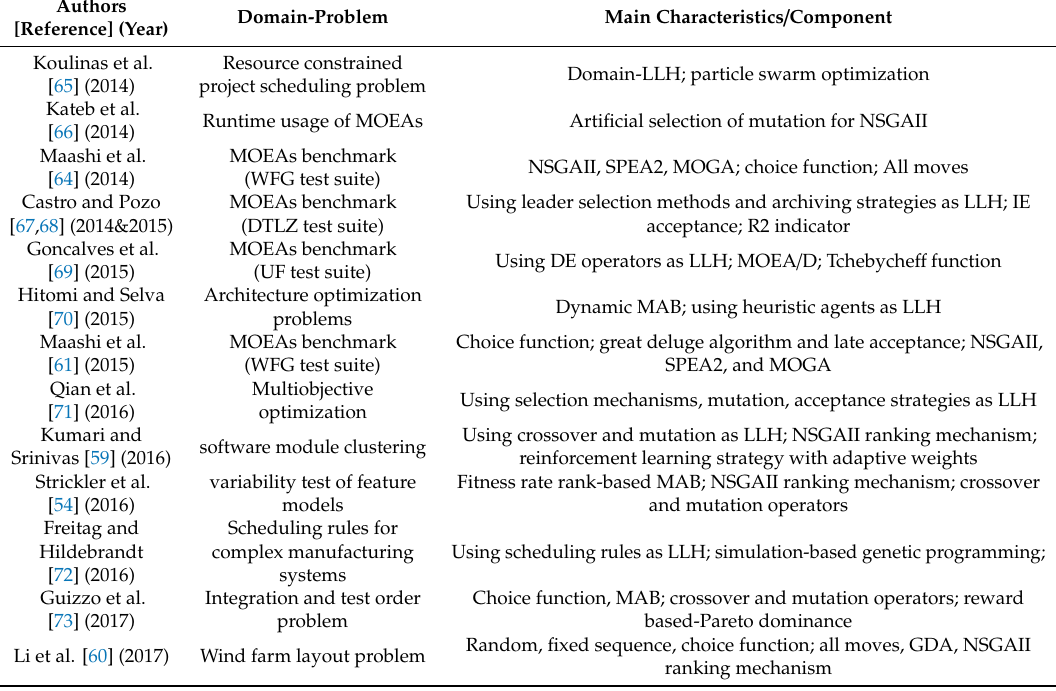
Table 2. Applications of MOHH since